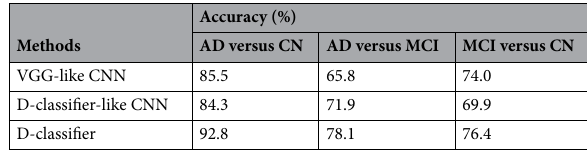
Table 6. Classification performance of three classifiers.